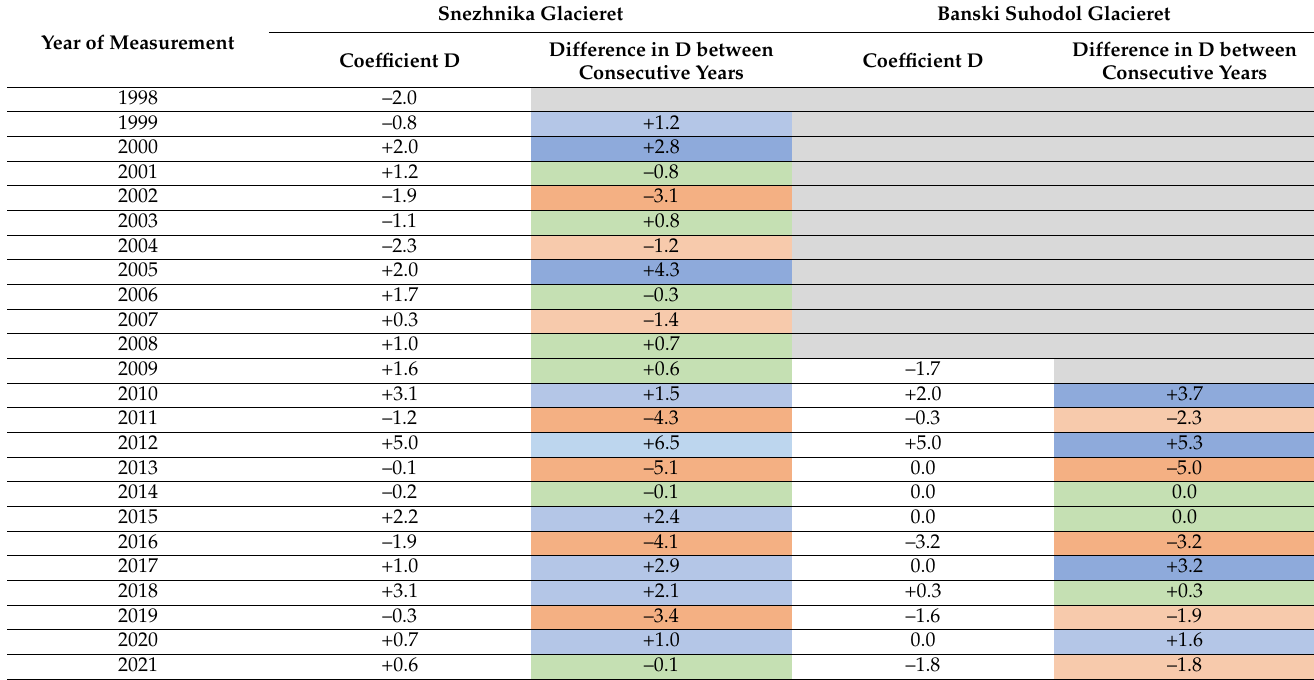
Colors represent the following: dark blue—sharp increase; light blue—moderate increase; green—slight change in position; light red—light drop; dark red—sharp drop. Positive values of D in Table 4 mean that for that particular year, the points, which illustrate the relationship between sum of positive daily temperatures and glacieret area, stand above the relationship line, i.e., the glacieret has increased its size more than